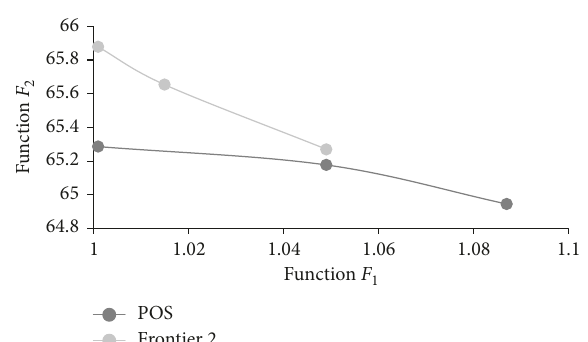
Figure 13: Objective functions F model RC-6.